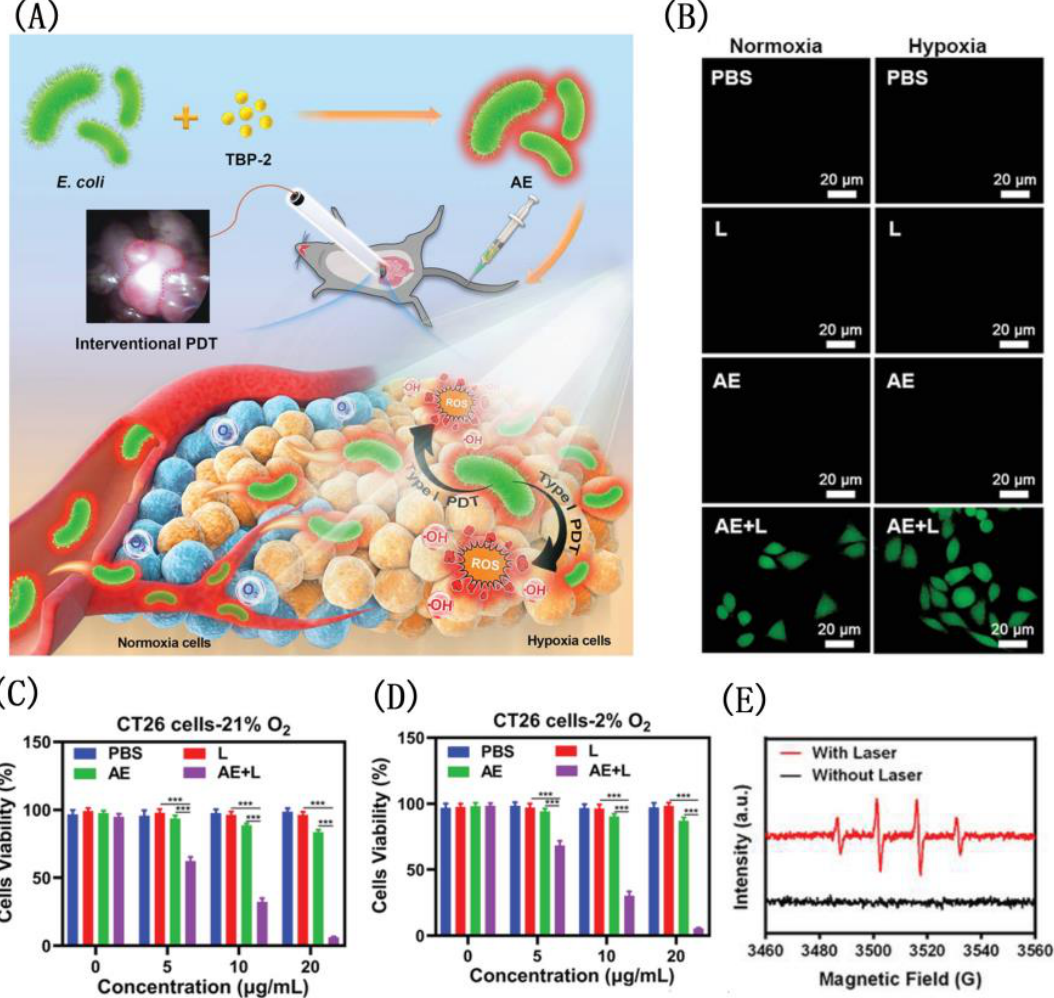
Figure 27. ( A ) The structure of TBP-2; viability of CT26 cells under normoxia ( B ) and ( C ) hypoxic conditions; ( D ) CLSM image of intracellular ROS; ( E ) schematic illustration of bright bacteria with TBP-2 for photodynamic therapy. Reprinted with permission from Ref. [186]. Copyright 2021 WILEY-VCH.